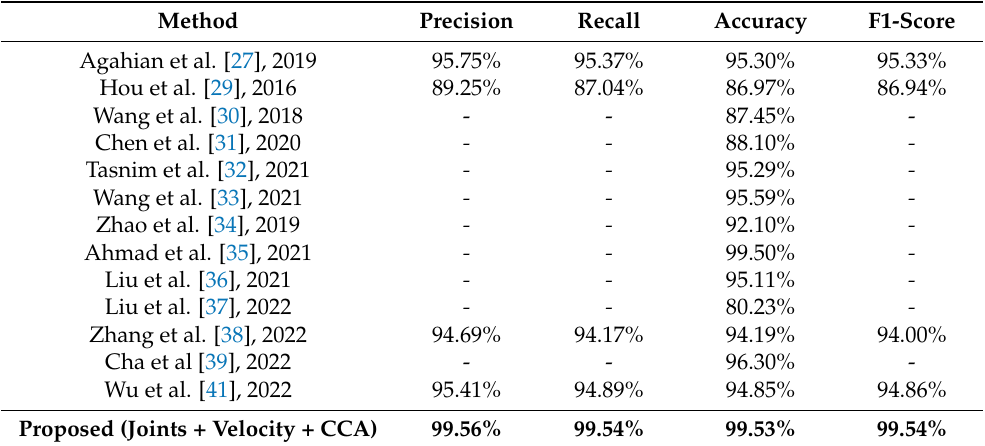
Table 3. Performance comparisons of HAR methods on the UTD-MHAD